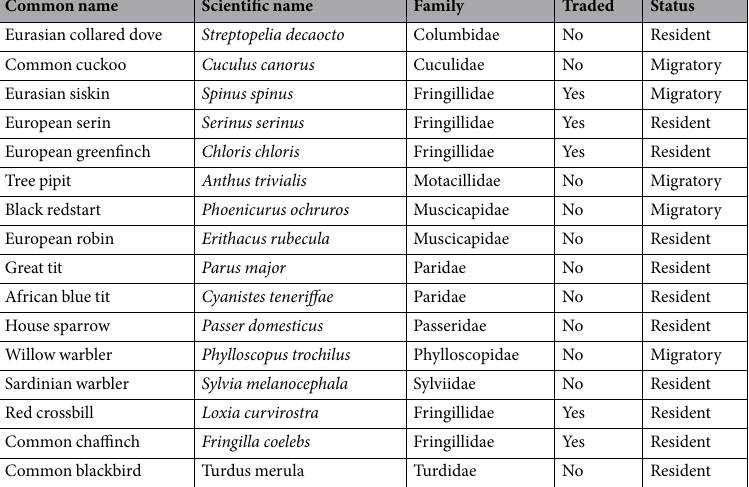
Table 2. Checklist with trading and migratory status of species captured as by-catch during the European goldfinch trapping by mist nets in three Algerian provinces. Algerian provinces are Guelma, Annaba, and Skikda, and are all located in the